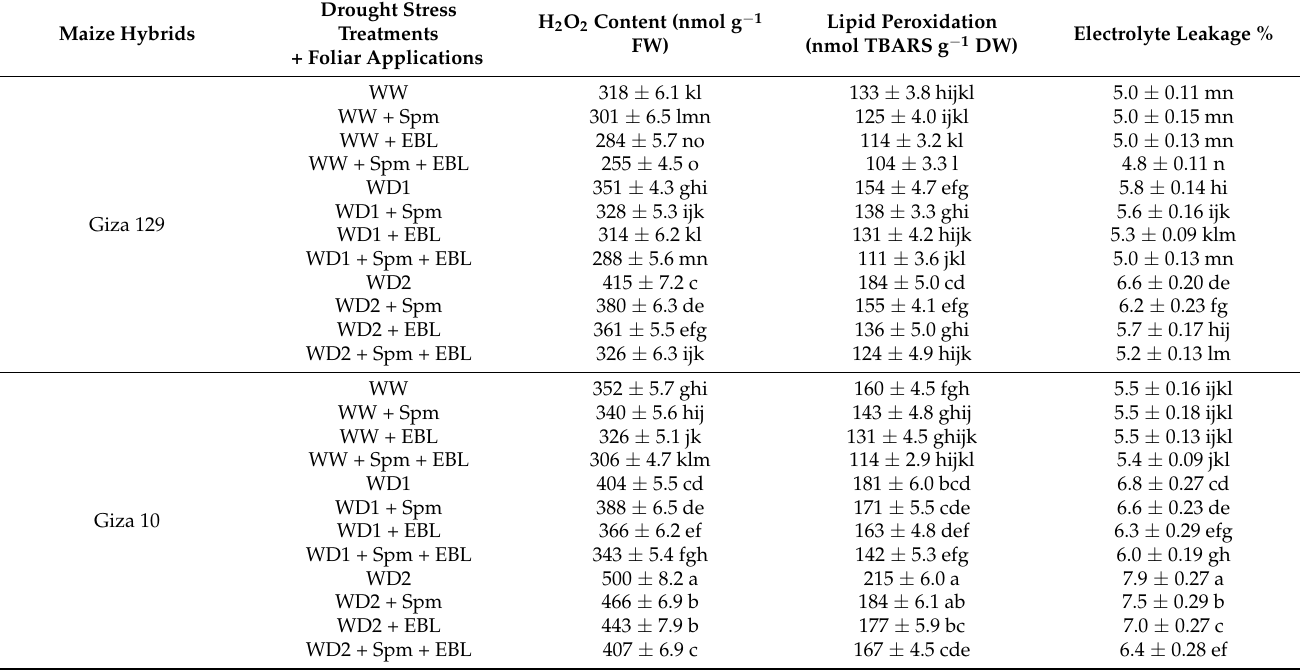
Table 4. Variations in hydrogen peroxide (H 2 O 2 ) content, lipid peroxidation, and electrolyte leakage of two maize genotypes—Giza 129 and Giza 10—grown under different drought stress treatments (control (100% field capacity (FC); WW) and water deficit (75% FC and 50% FC; WD1 and WD2)) and exposure to foliar applications of distilled water (control), 25 mg L − 1 Spm, 0.1 mg L − 1 EBL,